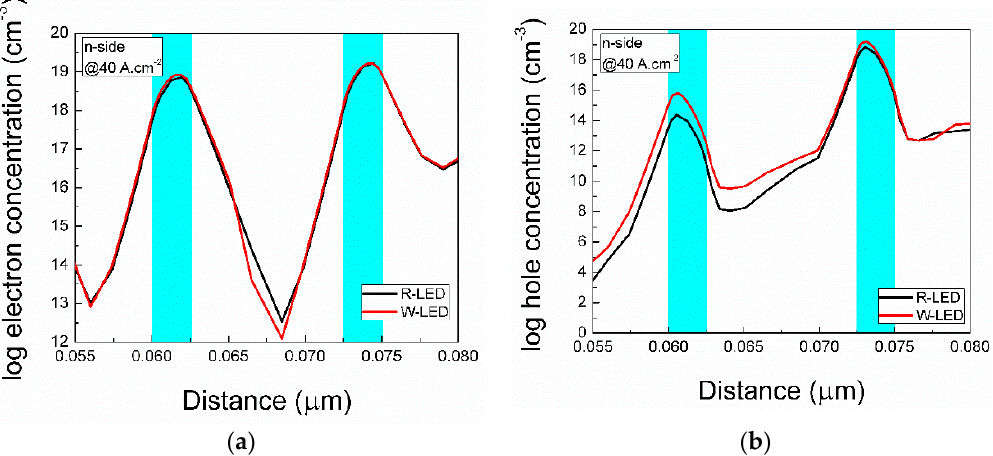
Figure 3. Comparison of carrier concentrations: ( a ) Electrons and ( b ) Holes in the two devices in semilogarithmic scale.